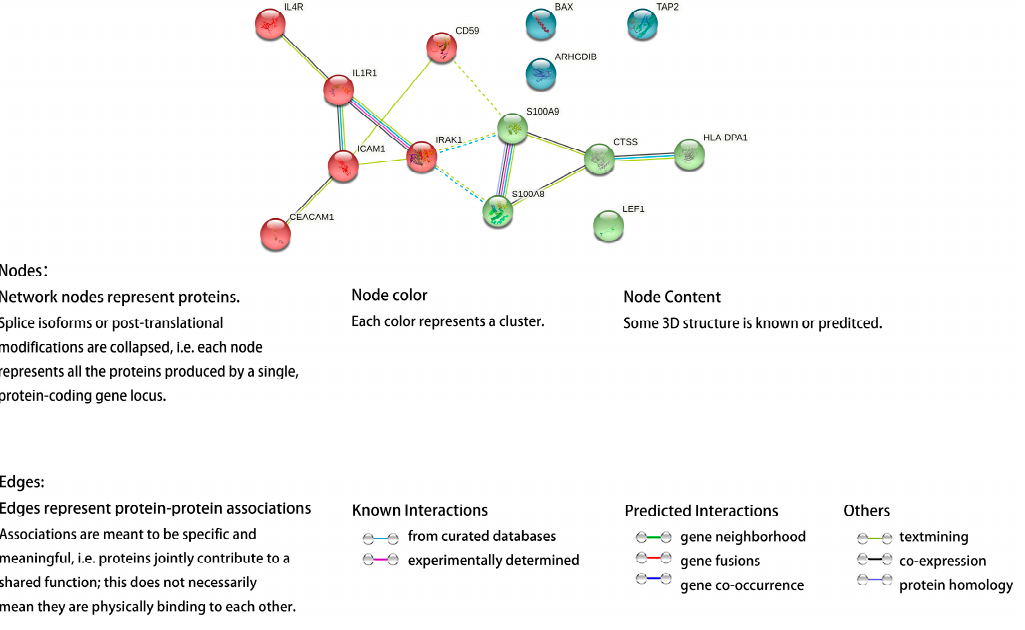
Table 1. Clinical data of the participants. Participant Number